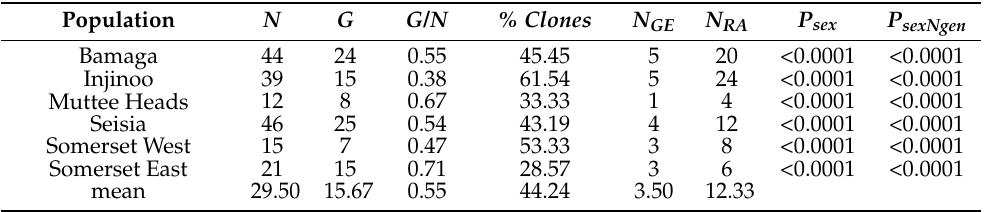
Table 1. Summary of clonal measures from Santalum lanceolatum populations across the Northern Peninsula Area of Cape York (Queensland, Australia) including all trees classified as either adult or